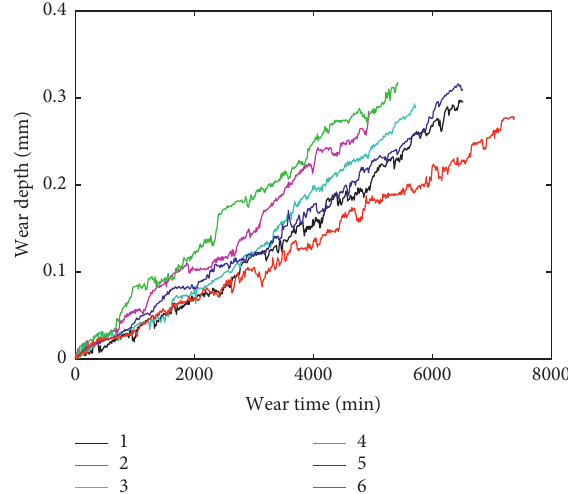
Figure 3: Wear curves of the self-lubricating liner.